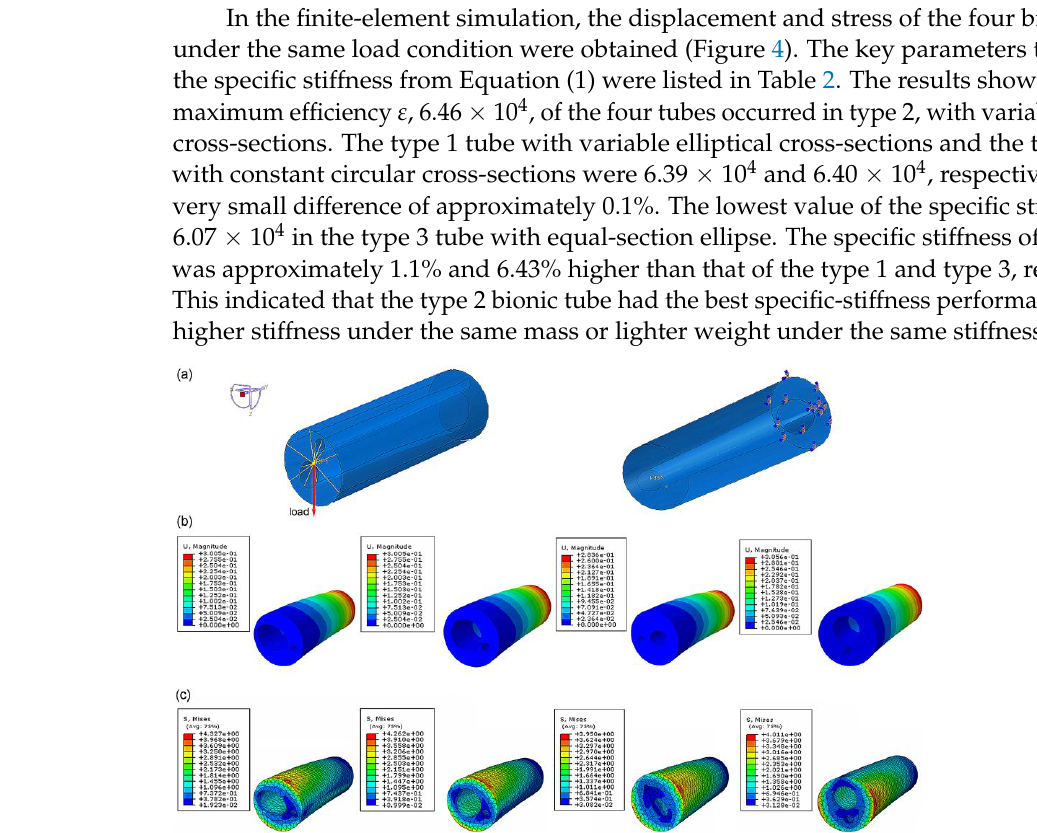
Figure 4. Finite-element analysis of bionic tubes: ( a ) loading conditions and boundary conditions; ( b ) distributions of the spatial displacement; ( c ) distributions of the maximum principal stress. Table 2. Finite-element analysis of the bionic tubes.